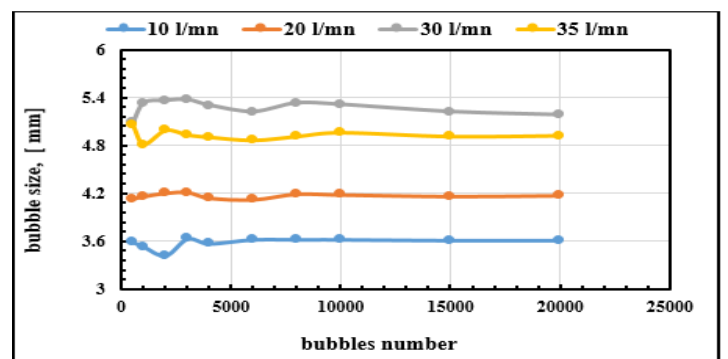
Figure 2. Convergence of gas holdup.